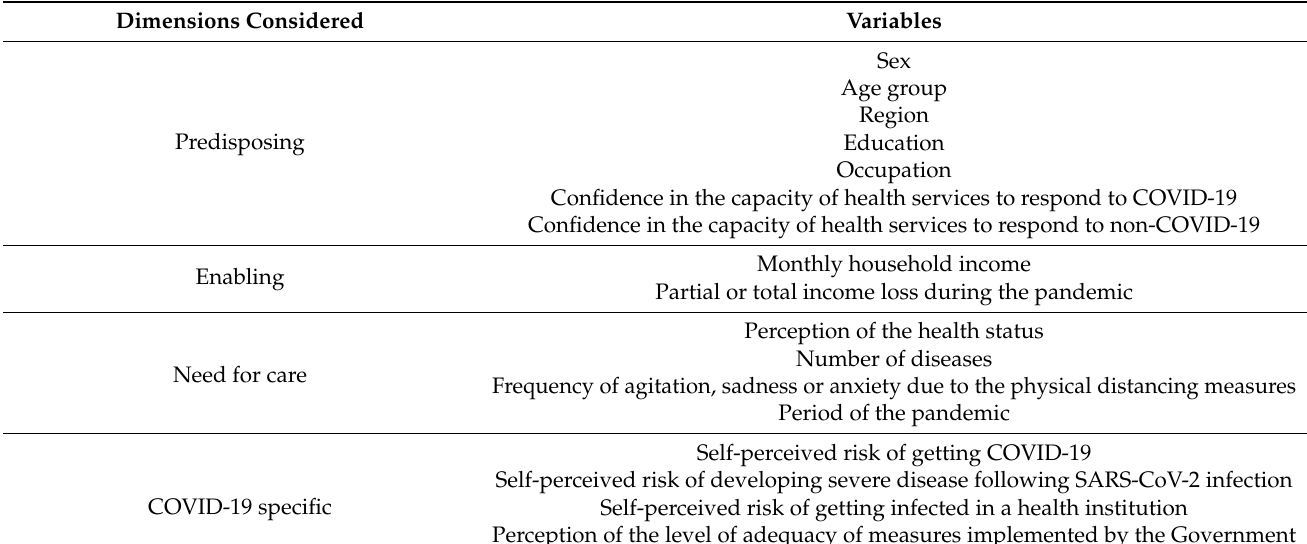
Table 1. Dimensions and variables considered for analysis, based on Andersen’s Behavioural Model [9,25]. Dimensions